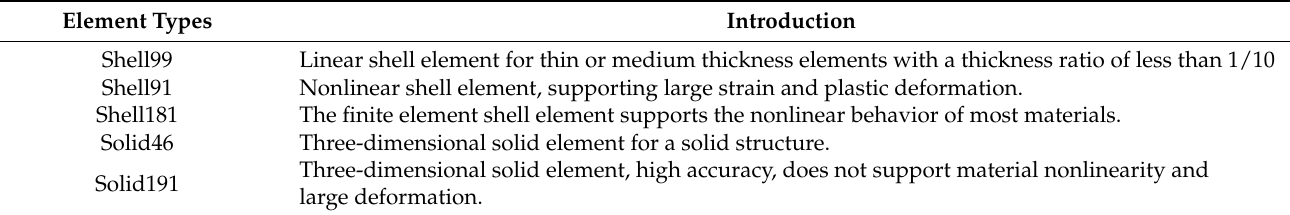
Table 1. Shell element categories and introduction [21].